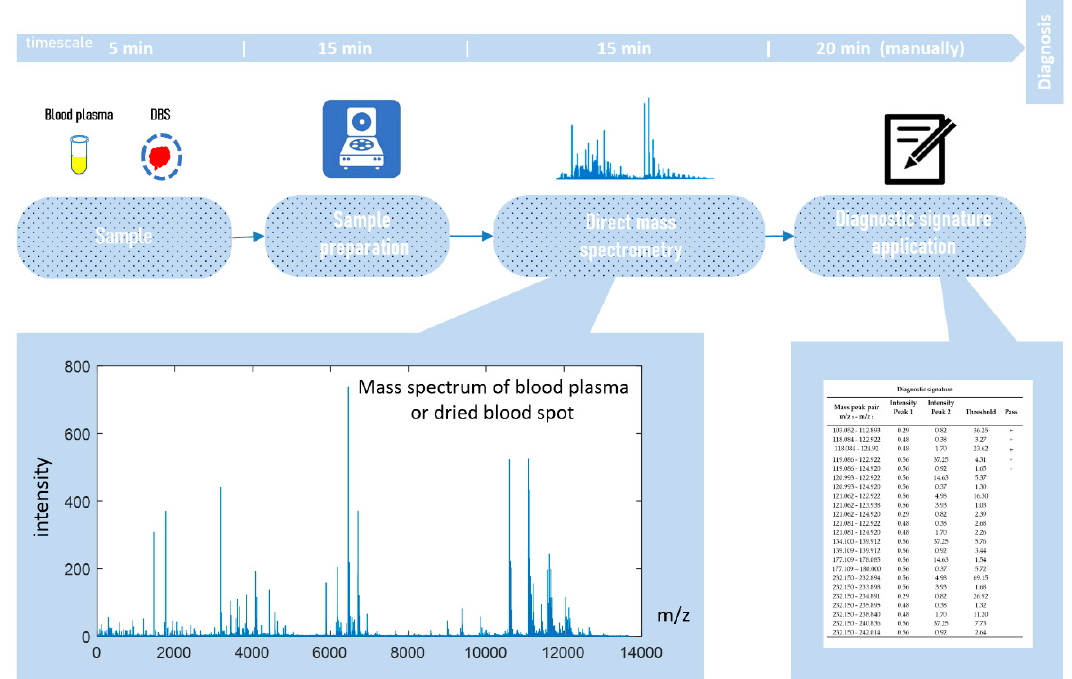
Figure 3. Workflow for in situ mass spectrometry diagnostics.